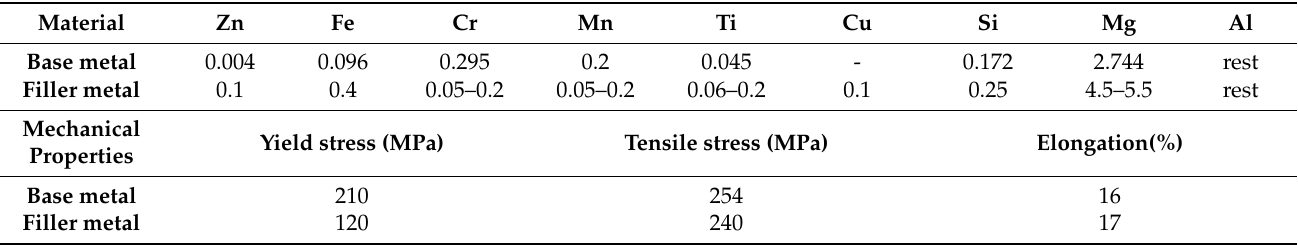
Figure 1. Schematics that show ( a ) sample size, ( b ) GTAW process, and ( c ) friction stir process. Table 1. Chemical compositions and mechanical properties of base metal (AA5052) and filler metal Ltd., Tokyo, Japan) and scanning electron microscopes (SEM, FEI Philips XL 30, Philips,